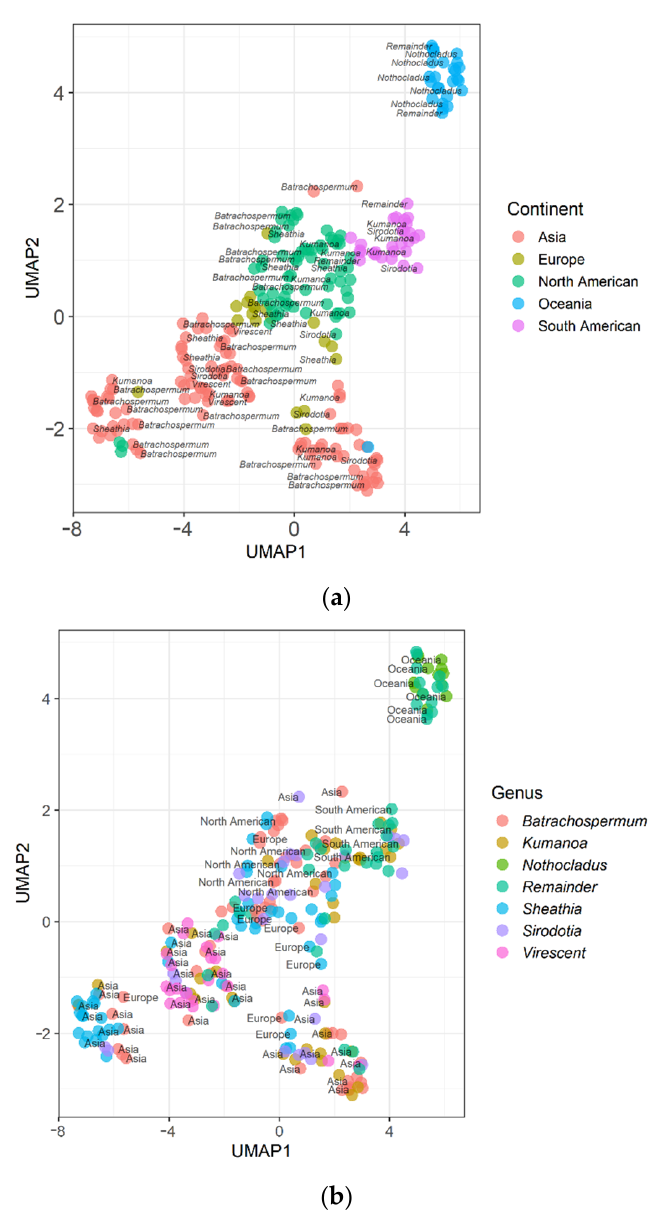
Figure 3. Clustering results of UMAP. ( a ) Clustering results of Batrachospermaceae among continents; ( b ) Clustering results of UMAP among the genus of